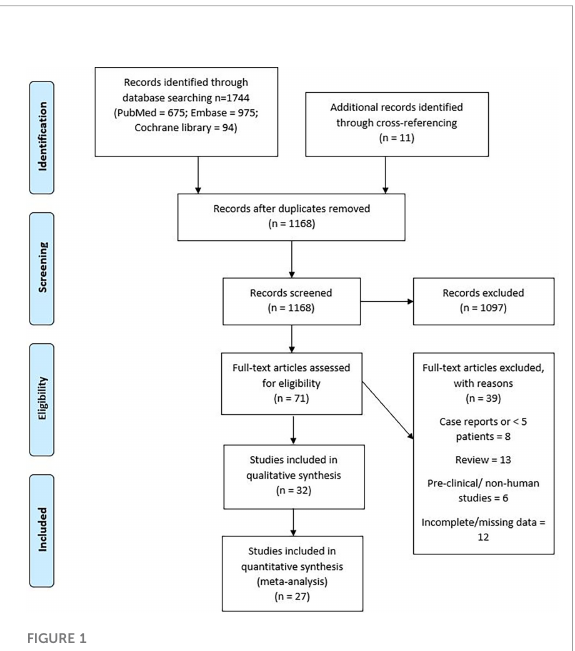
FIGURE 1 PRISMA fl ow diagram, depicting the search